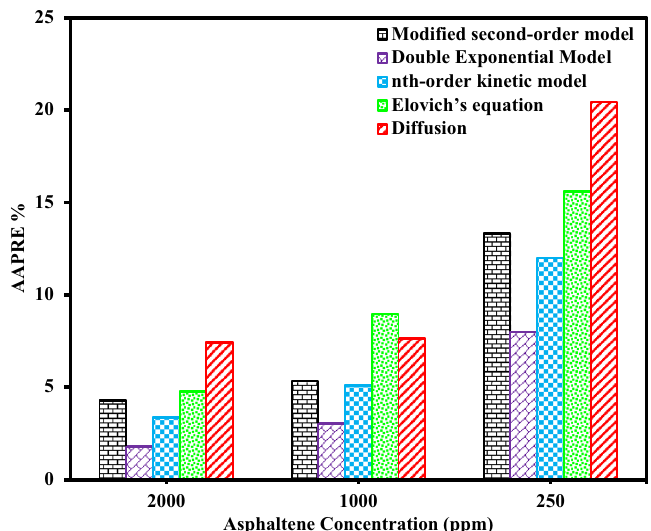
Figure 10. Comparison of deposition kinetics models at different asphaltene concentrations for PTFE coatings at dynamic state based on AAPRE.